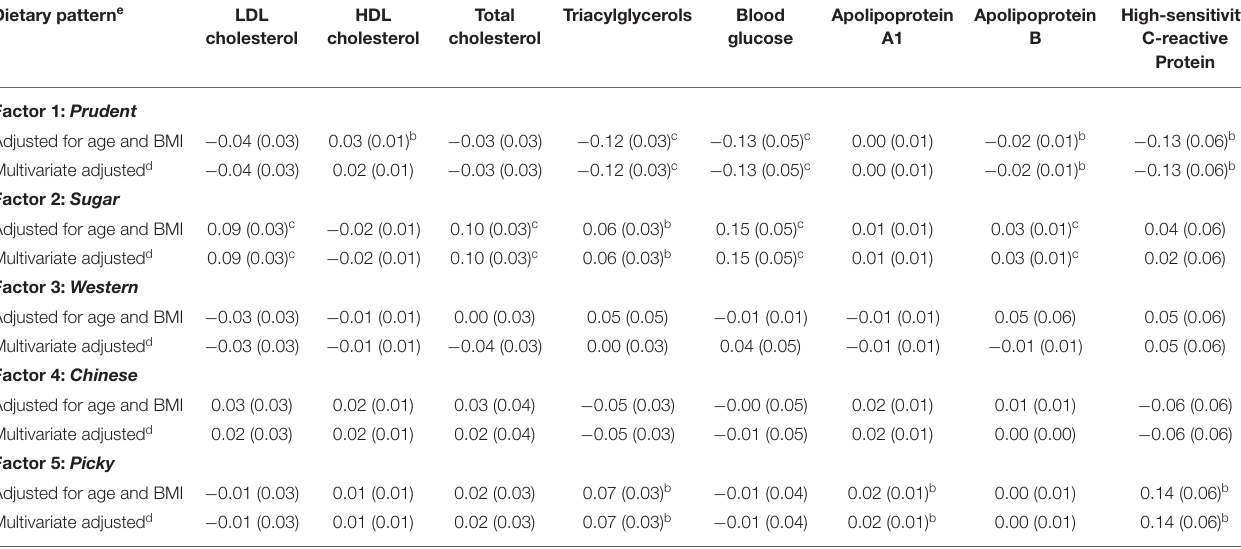
TABLE 4 | Association between dietary patterns (factors) and plasma lipid biomarkers, regression coefficients ( β ) a . Dietary pattern e LDL